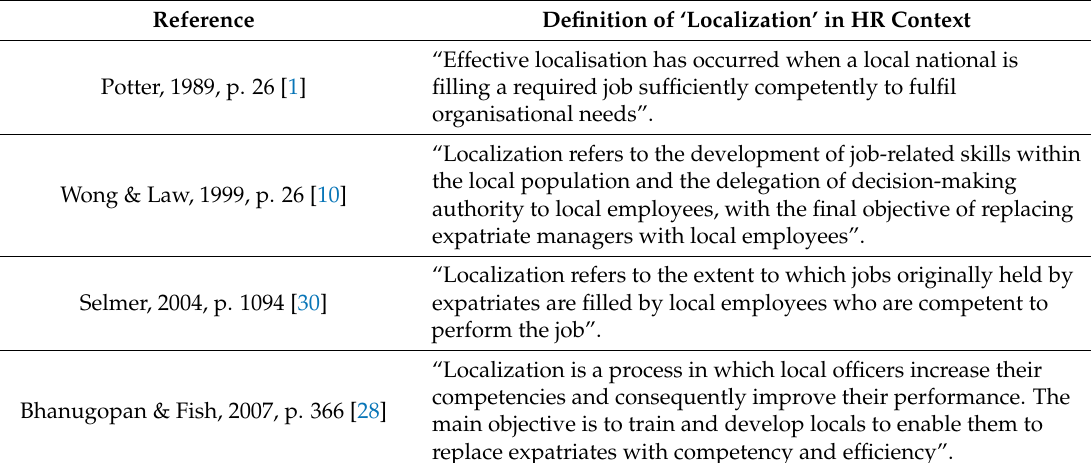
Table 2. Definitions of ‘job role localization’ (source: